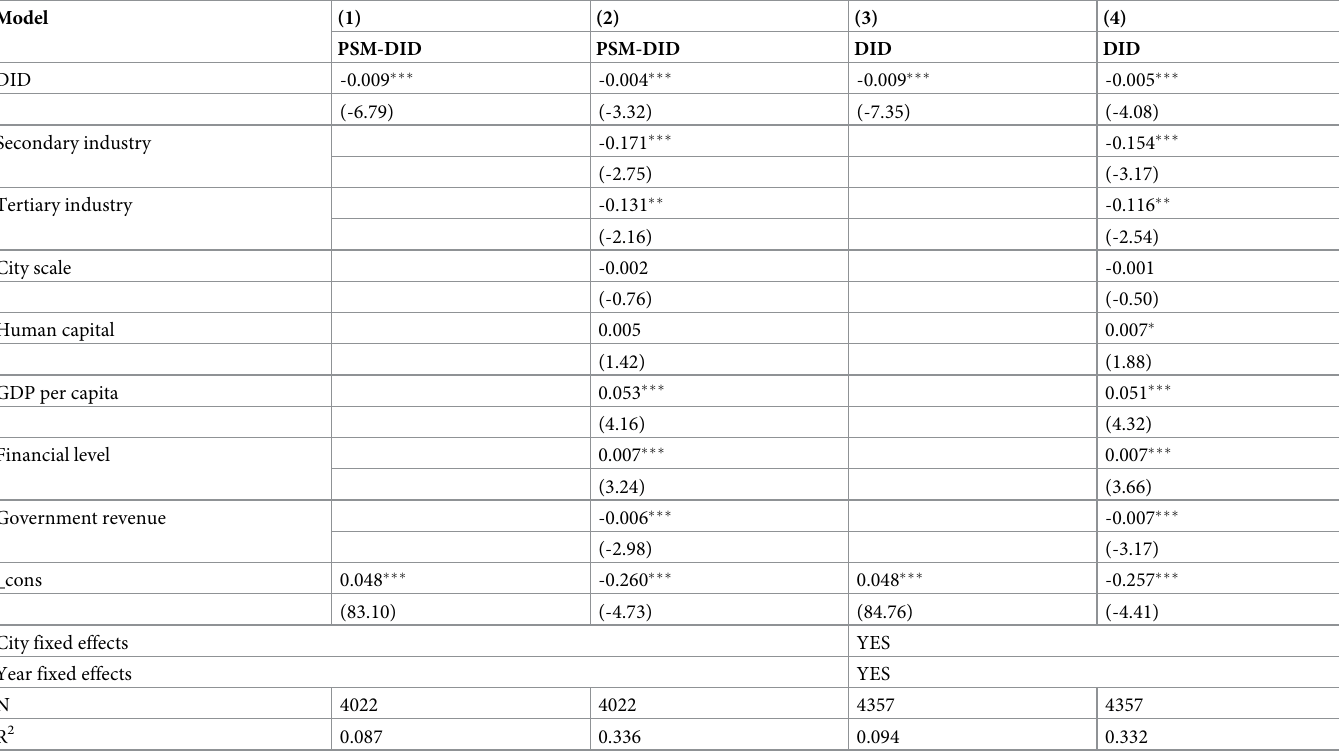
Table 7. Evaluation results of the policy impact on the quality of public services per capita (Explained variable: Public services per